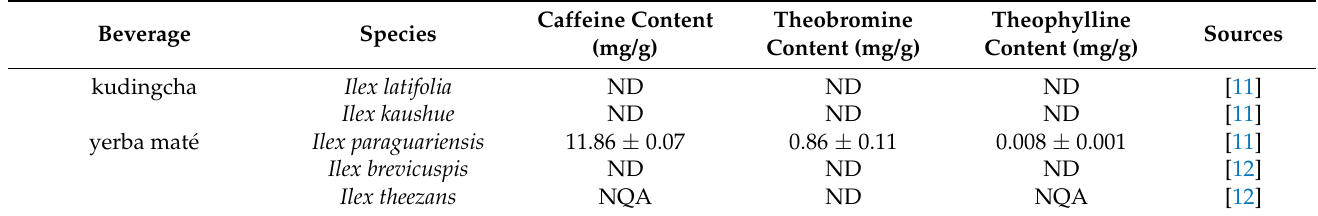
Table 1. Xanthine (caffeine, theobromine, and theophylline) contents in source plants of different holly beverages. ND means no detection; NQA means no quantifiable amount. All these contents were calculated based on 1 g dry weight. Note that several early reports of caffeine content have not been confirmed by subsequent studies with improved techniques and are not included here.